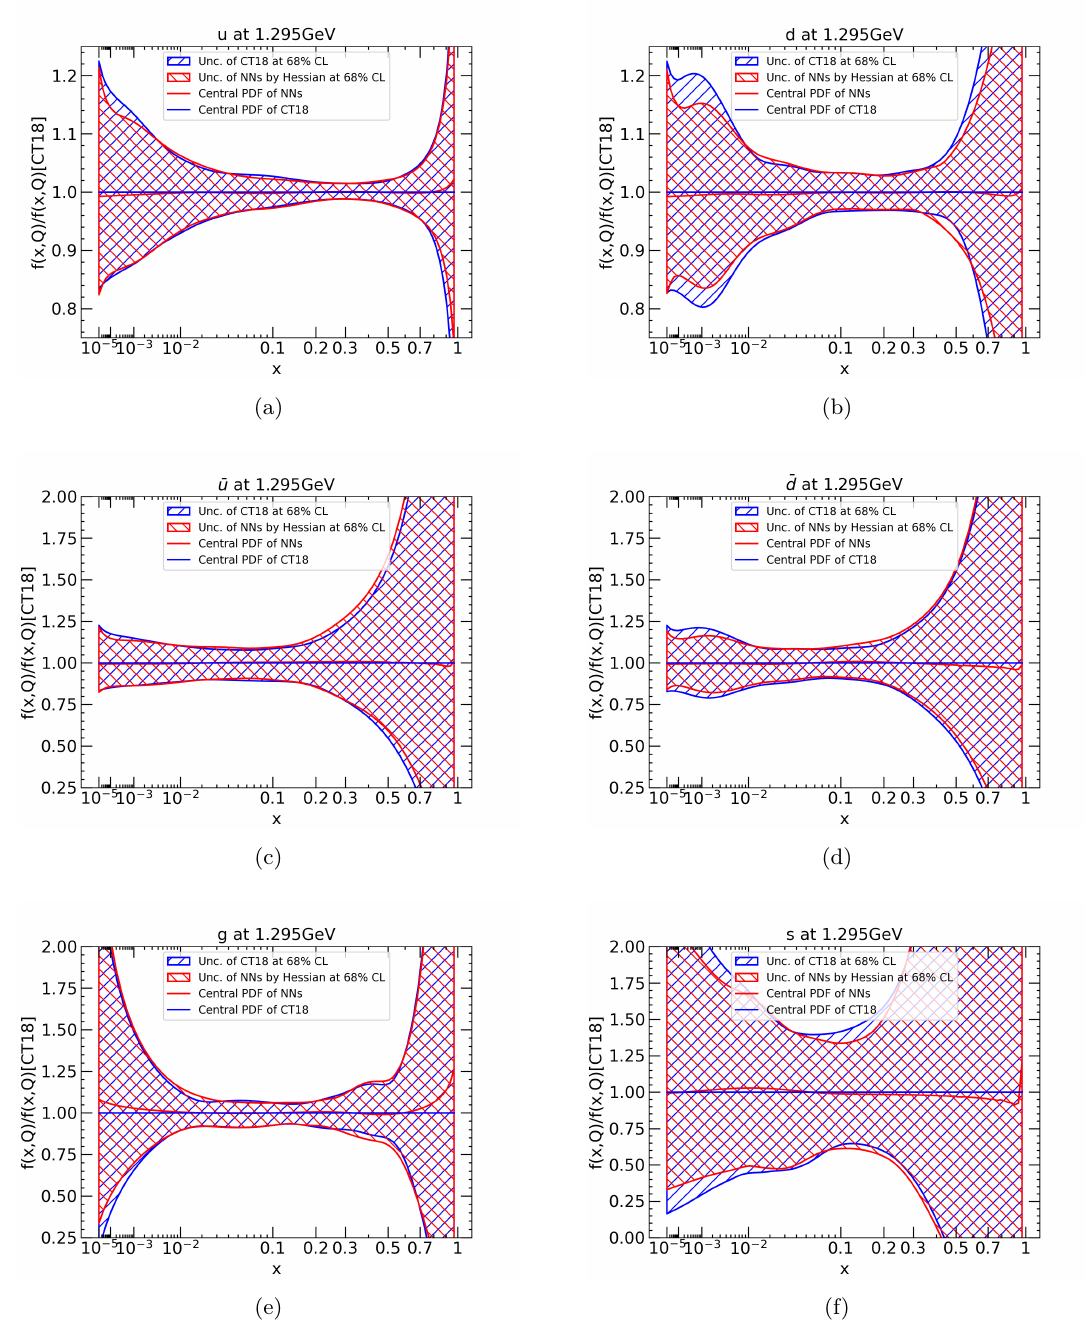
¯ d , g and s . The blue